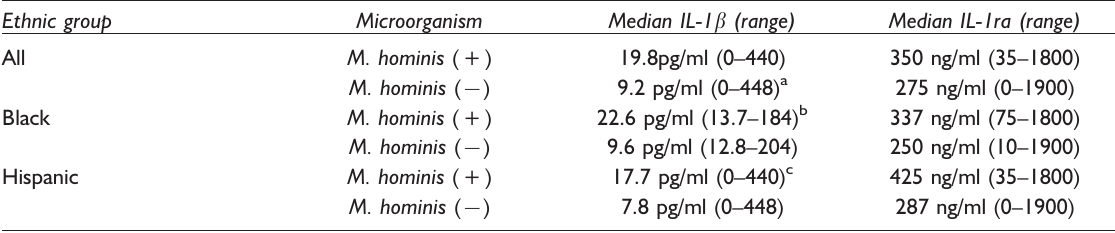
Table 2 Relation between M. hominis vaginal colonization, ethnicity and vaginal concentrations of IL-1 b and IL-1ra Ethnic group